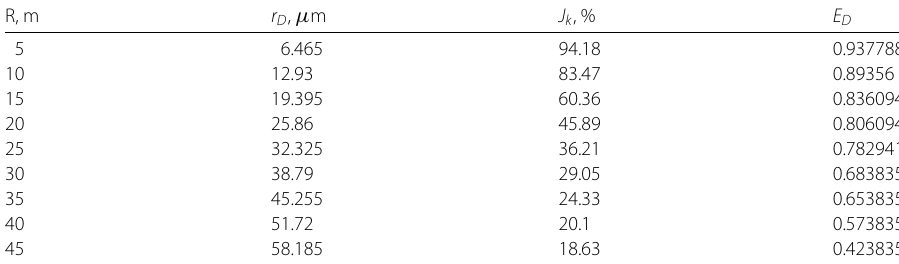
Figure 4 Occurrence radius in different pressure gradient